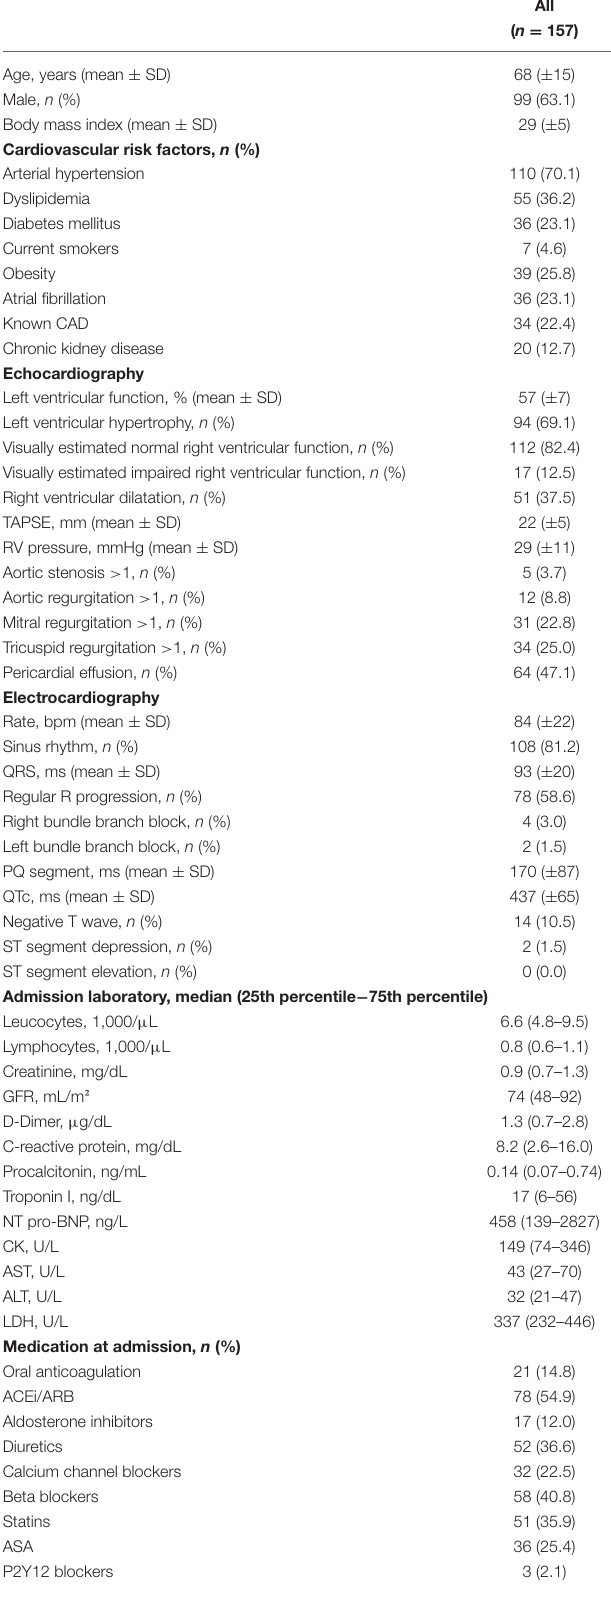
TABLE 1 | Baseline characteristics of the overall cohort ( n =